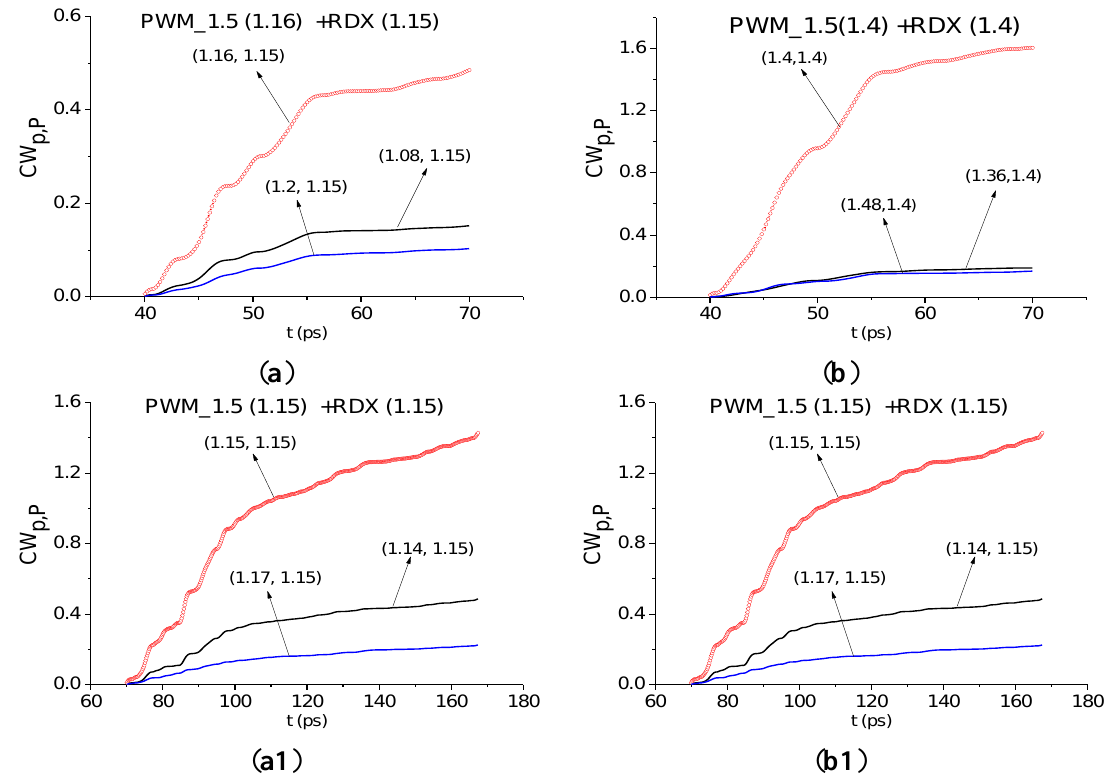
Figure 28. Integral characteristics detecting the frequencies ν = 1.16 THz ( a ); 1.4 THz ( b ) in the time interval t = [40, 65] ps; ν = 1.15 THz ( a1 ); 1.4 THz ( b1 ) in the time interval t = [70, 170]